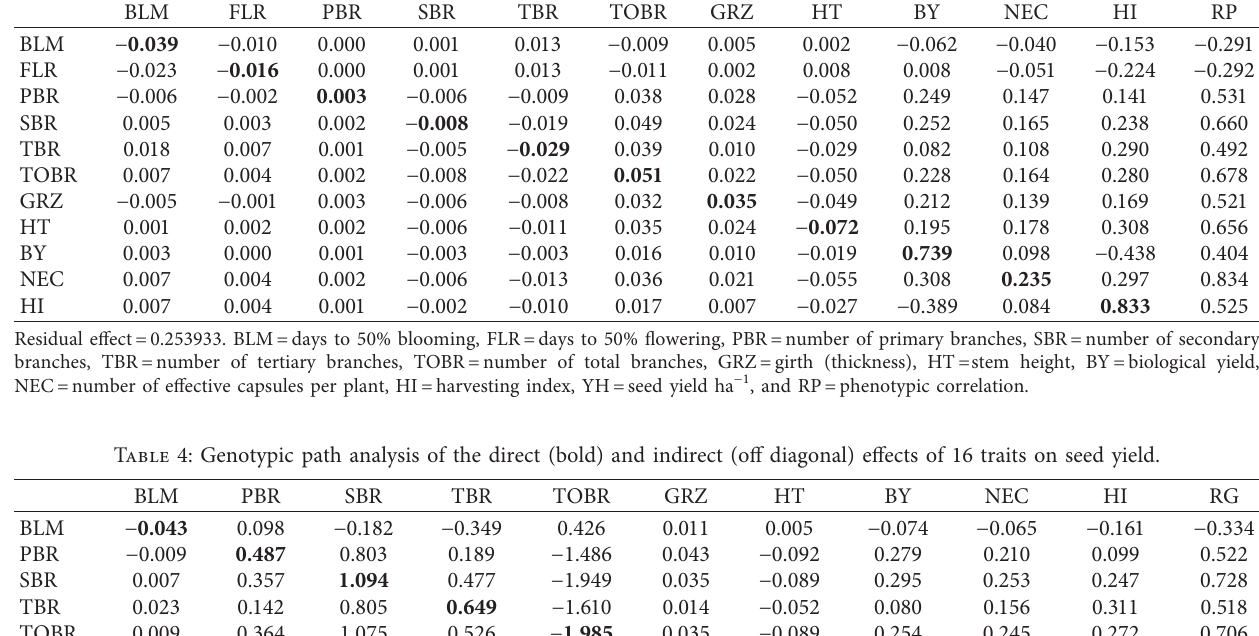
Table 3: Phenotypic direct (bold) and indirect effect (off diagonal) of 16 traits on grain yield.